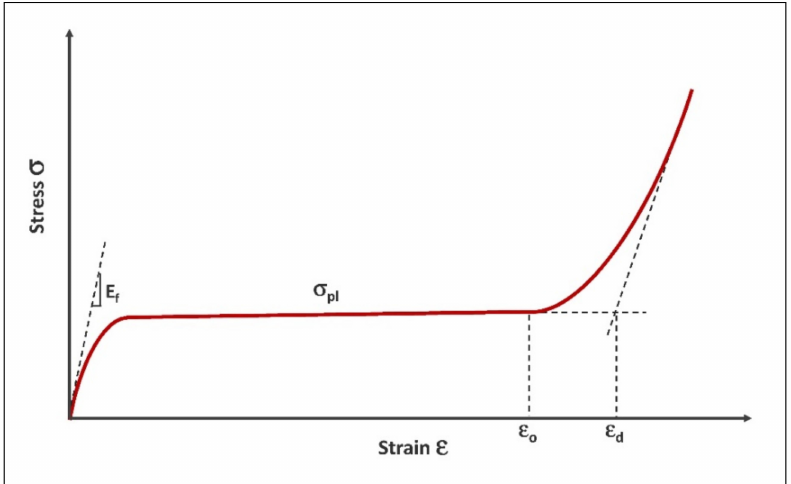
Figure 3. Schematic compression stress–strain curve for metal